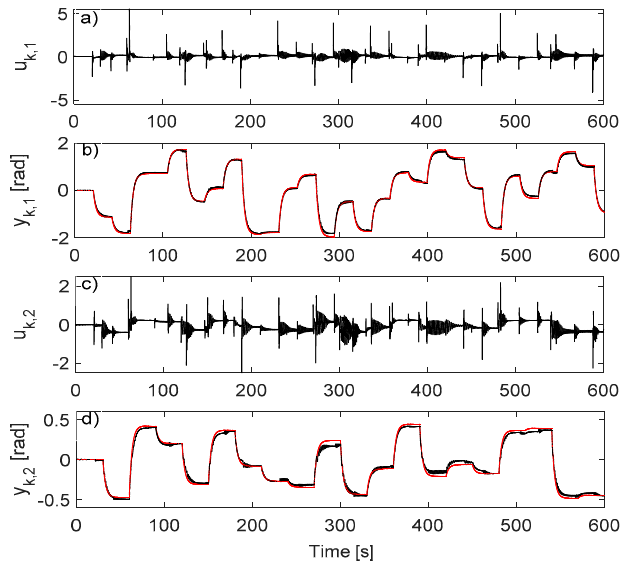
Figure 2. VSFRT neural network (NN) controller: ( a ) u k ,1 ; ( b ) y k ,1 (black), y m